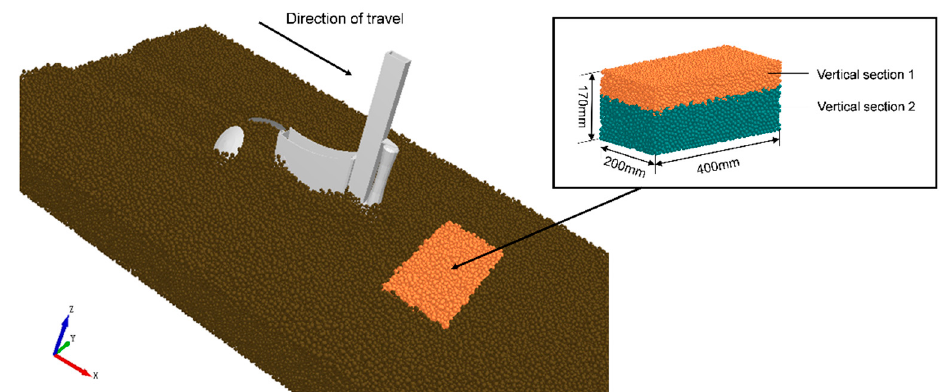
Figure 8. Simulation model of cover device and trough.